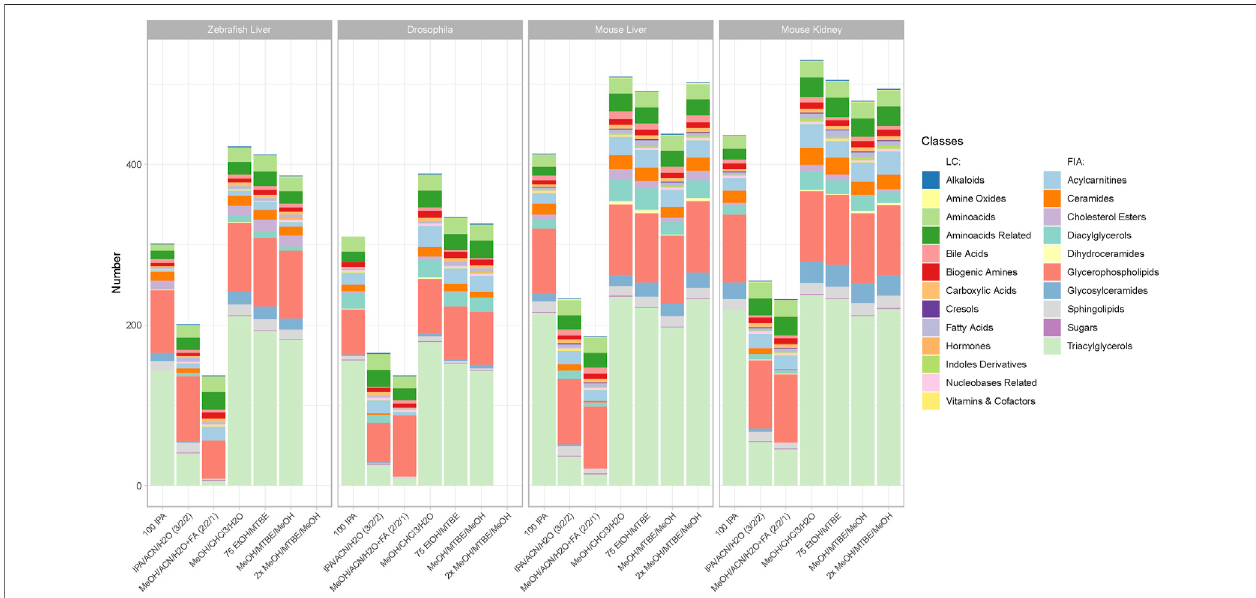
FIGURE 2 | Metabolite coverage per extraction protocol across all sample types and model organisms. Indicated by color are the different metabolite classes measured. Ametabolite was counted asdetectable when at least 2out of3replicates were > LOD within agiven extraction protocol. Thelegend iscategorizedbetween compound classes measured via LC-MS/MS or FIA-MS/MS. Ordering from left to right follows the level of complexity and required time per extraction.